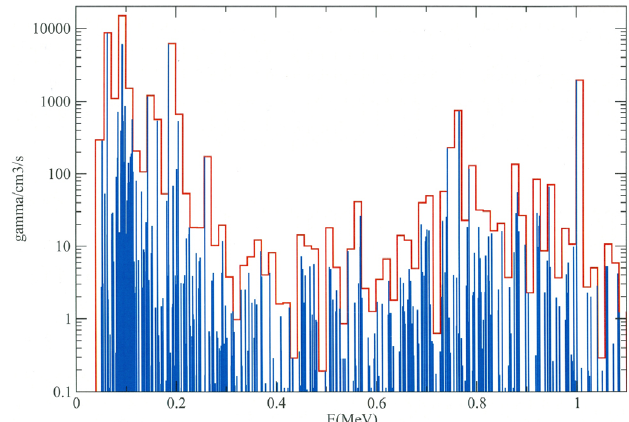
Fig. 2. Gamma source lines (blue) are condensed into groups (red) for multigroup S